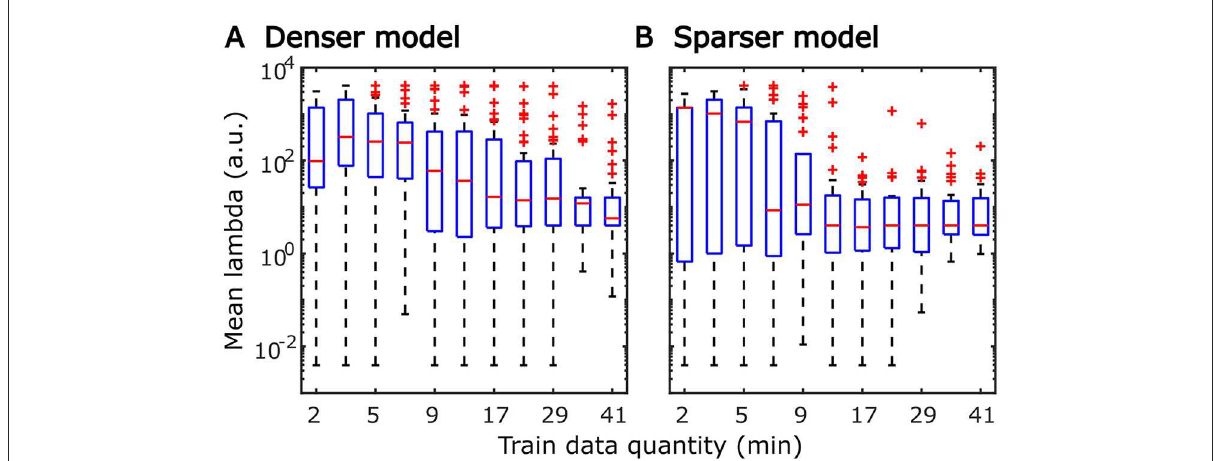
FIGURE6 Distributions of subject-specific regularization parameters, lambda, from the denser (A) and sparser (B) models, as a function of training data quantity. Red horizontal lines within each box represent the median value while the lower and upper bounds of the blue boxes depict the 25th and 75th percentiles of the distributions. To aid the visualization of where bulk of the data points were, unusually large parameters (for a given data quantity) were marked as outliers with red “ + ” symbols. “a.u.” denotes arbitrary